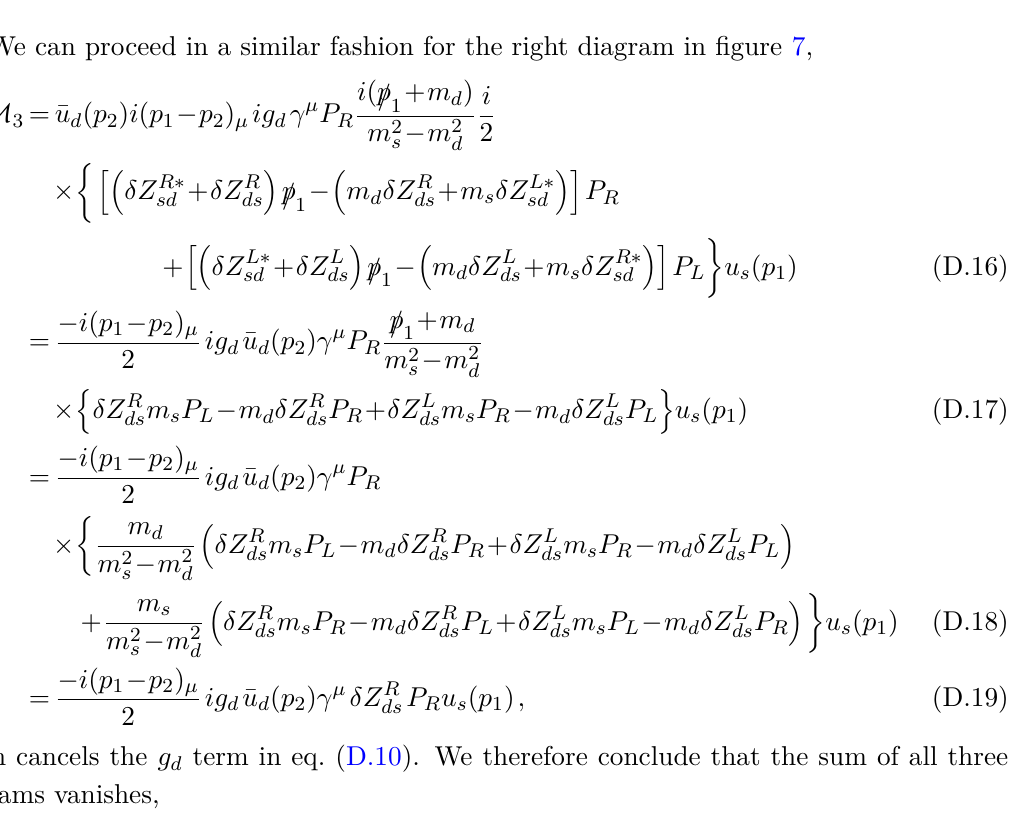
Figure 10 . One-loop contributions to photon interactions with quarks in our UV model, which are of relevance for the EDM